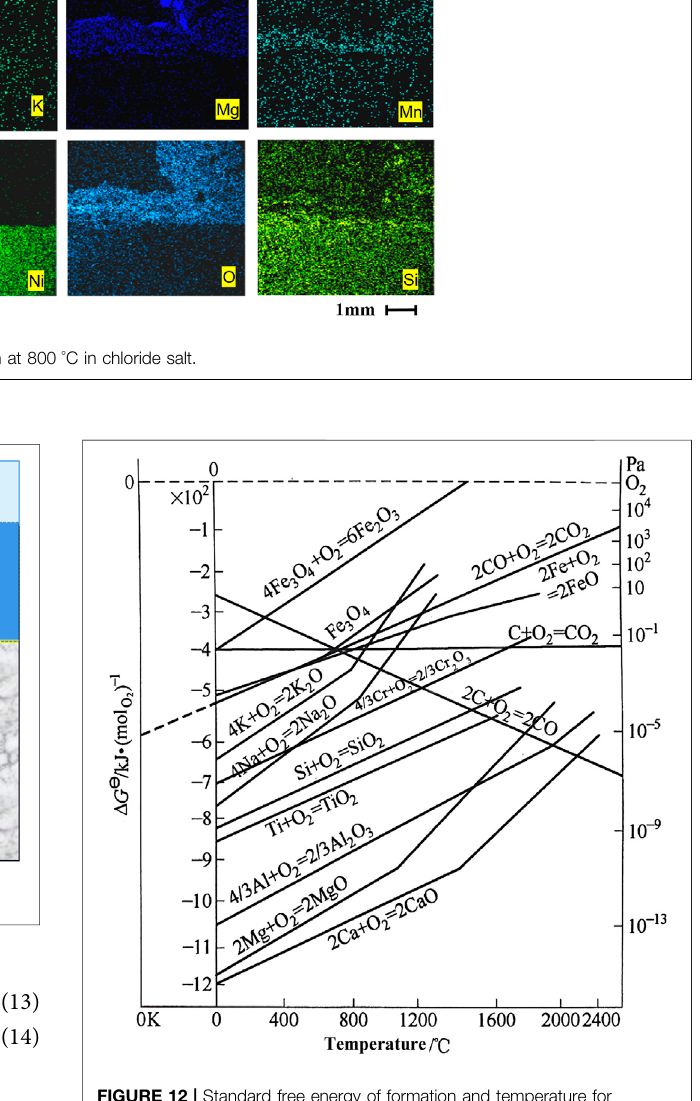
FIGURE 12 | Standard free energy of formation and temperature for oxides (Xu,